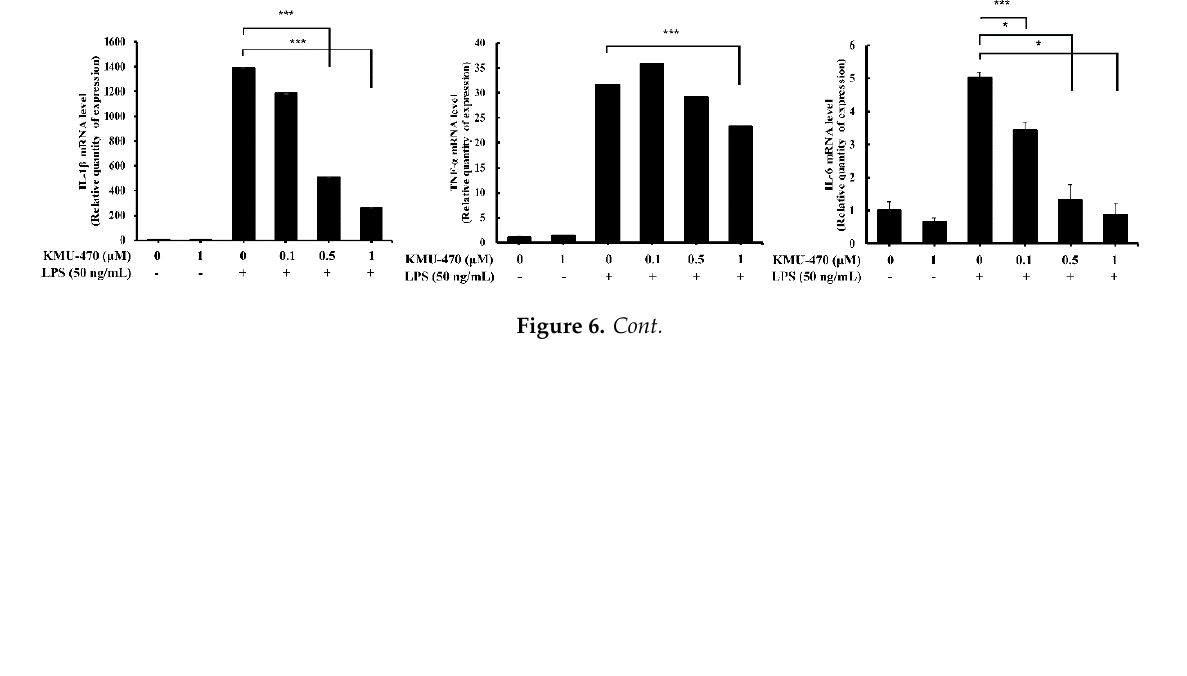
Figure 6. Inhibitory effect of KMU-470 on LPS-induced up-regulation of pro-inflammatory cytokines and activation of NLRP3 inflammasome in RAW 264.7 cells. ( A , B , C ) Cells were treated with KMU- 470 for 30 min and stimulated with LPS 50 ng/mL for 6 h. The levels of IL-1β, TNF-α, and IL-6 were determined using real time PCR. *** p < 0.001, * p < 0.05. ( D ) Cells were pre-treated with 0.1, 0.5, and 1 μM of KMU-470 for 30 min and treated with LPS 50 ng/mL for 6 h, respectively. Whole cell lysates were isolated and used to measure the protein expression levels of pro-IL-1β and β-actin by Western blot analysis. ( E ) Cells were pre-treated with 0.1, 0.5, and 1 μM of KMU-470 for 30 min and treated with LPS 50 ng/mL for 6 h, respectively. Whole cell lysates were isolated and used to measure the protein expression levels of NLRP2, ASC, pro-caspase-1, pro-IL-1β , and β-actin by Western blot analysis. 2.7. KMU‐470 Decreased LPS‐Induced Pro‐Inflammatory Cytokines in RAW 264.7 Cells We investigated the effect of KMU‐470 on LPS-mediated regulation of inflammatory cytokines. KMU‐470 significantly decreased LPS-induced up-regulation of pro-inflammatory cytokines including IL-1β, TNF-α, and IL-6 in RAW 264.7 cells (Figure 6A–C). Moreover, KMU-470 reduced LPS-induced up-regulation of IL‐1β protein (Figure 6D). These results indicate that KMU‐470 effectively inhibited LPS‐mediated up‐regulation of pro‐inflammatory cytokines. 3. Discussion Members of the PIM kinase family are known as oncogenes, and many studies have been conducted on the role of PIM in tumorigenesis [12]. Recently, studies on the function of the PIM kinase family in the inflammatory response have been attracting attention. PIM‐1, one of the three PIM kinases, is significantly induced by cigarette smoke in RAW 264.7 cells [7], and the inhibition of PIM‐1 in a dextran sodium sulfate colitis mice model improved colitis by reducing the excessive activity of macrophages and the immune response of Th1 and Th17 [5]. In addition, PIM‐1 kinase inhibitors effectively prevent the generation of cytokines, which cause allergic inflammation of the airways [6]. These findings highlight the importance of PIM‐1 kinase in inflammatory responses. However, the exact mechanisms by which PIM kinases influence the inflammatory process remain unknown. In the present study, we developed a novel PIM kinase inhibitor and investigated its anti‐ inflammatory mechanism in RAW 264.7 cells.